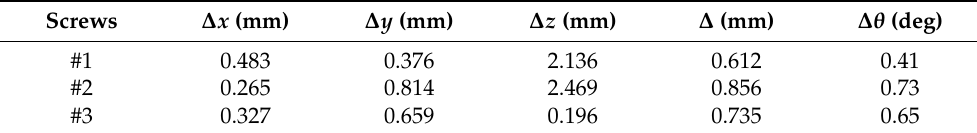
Table 4. Errors between the calculated and desired screw